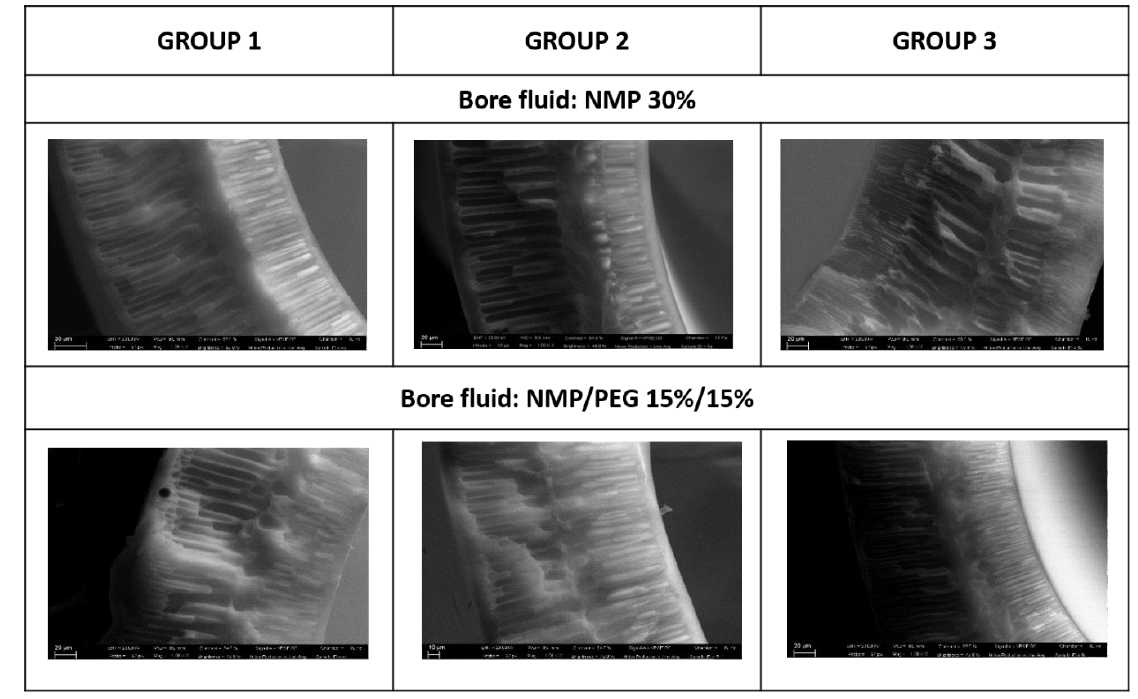
Figure 3. Morphology of the fibers spun from experiment Groups 1–3 using two different bore fluids (NMP 30% and NMP/PEG 15%/15%).